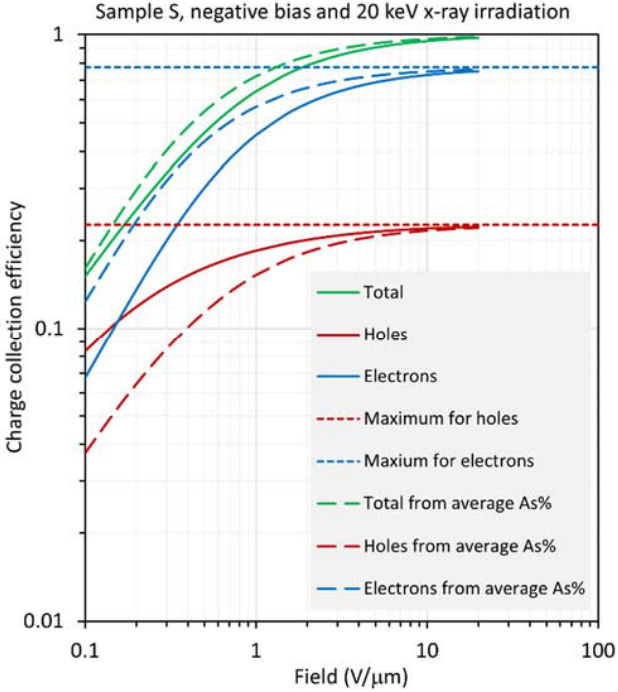
Figure 11. Log–log plot of the CE as a function of field for sample S (near worst case), biased negatively and exposed to X-rays with a photon energy of 20 keV, so that δ / L =0.243.